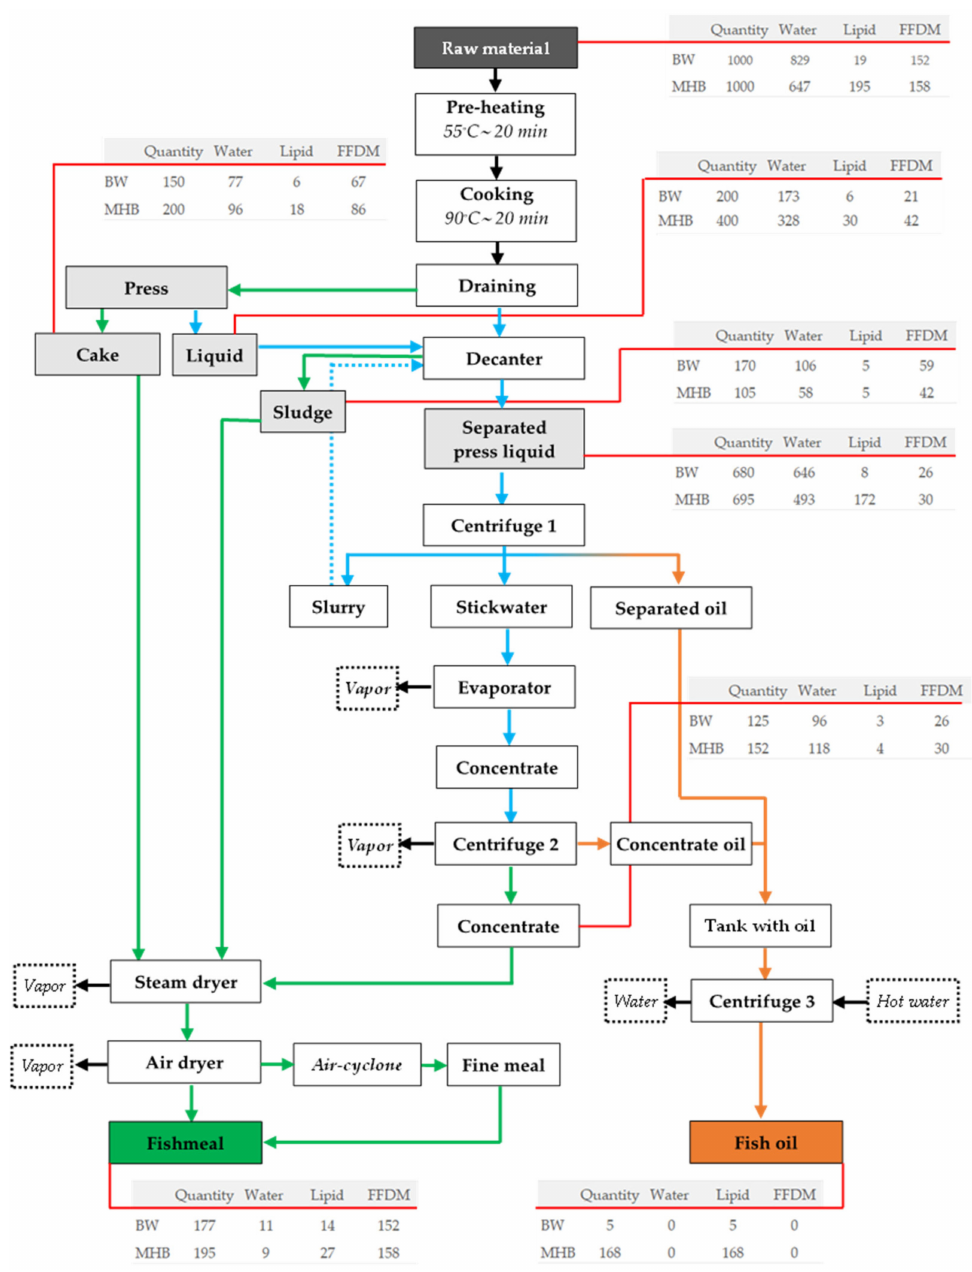
Figure 1. Industrial fishmeal and fish oil production process. The green colour indicates the solid streams throughout the process, the blue represents the liquid streams, and the yellow colour expresses the oil streams. Mass balance from 1000 kg of raw material was calculated for blue whiting (BW) and mackerel/herring blend (MHB), shown by red lines. The quantity of each processing stream and the amounts of water, lipid, and fat-free dry matters (FFDM) in each stream are shown in kg. The flow chart was adapted from Hilmarsdottir et al.